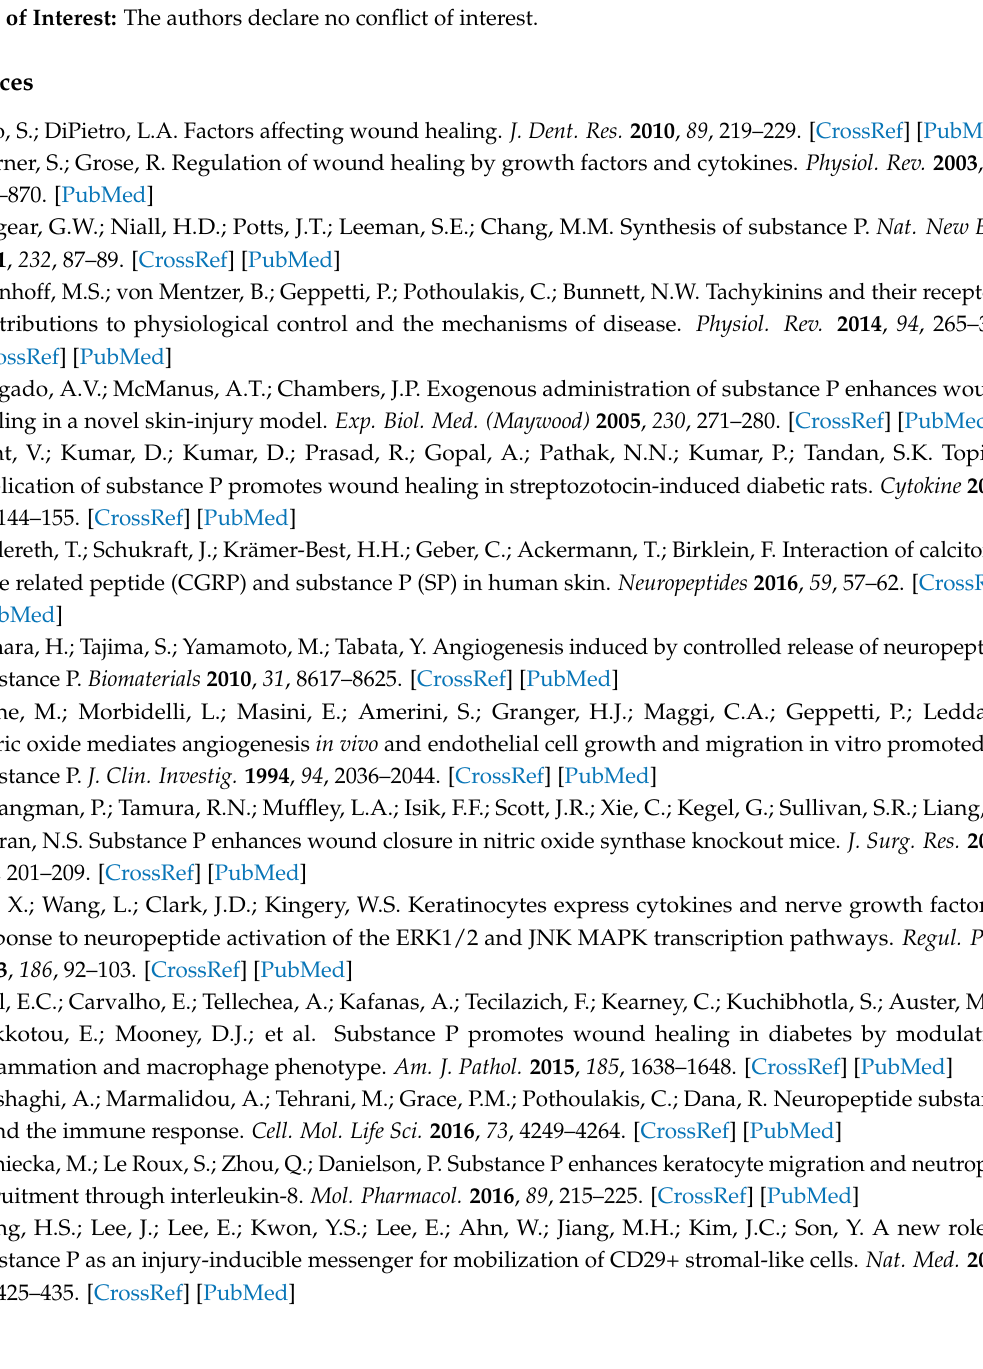
Figure S1: Exemplary pictures of time course wound healing. ( A ) shows wound progression without treatments (control), while ( B ) and ( C ) illustrate the wound progression after treatment with free SP 1 × 10 − 5 M and SP-CH-LP 1 × 10 − 5 M,